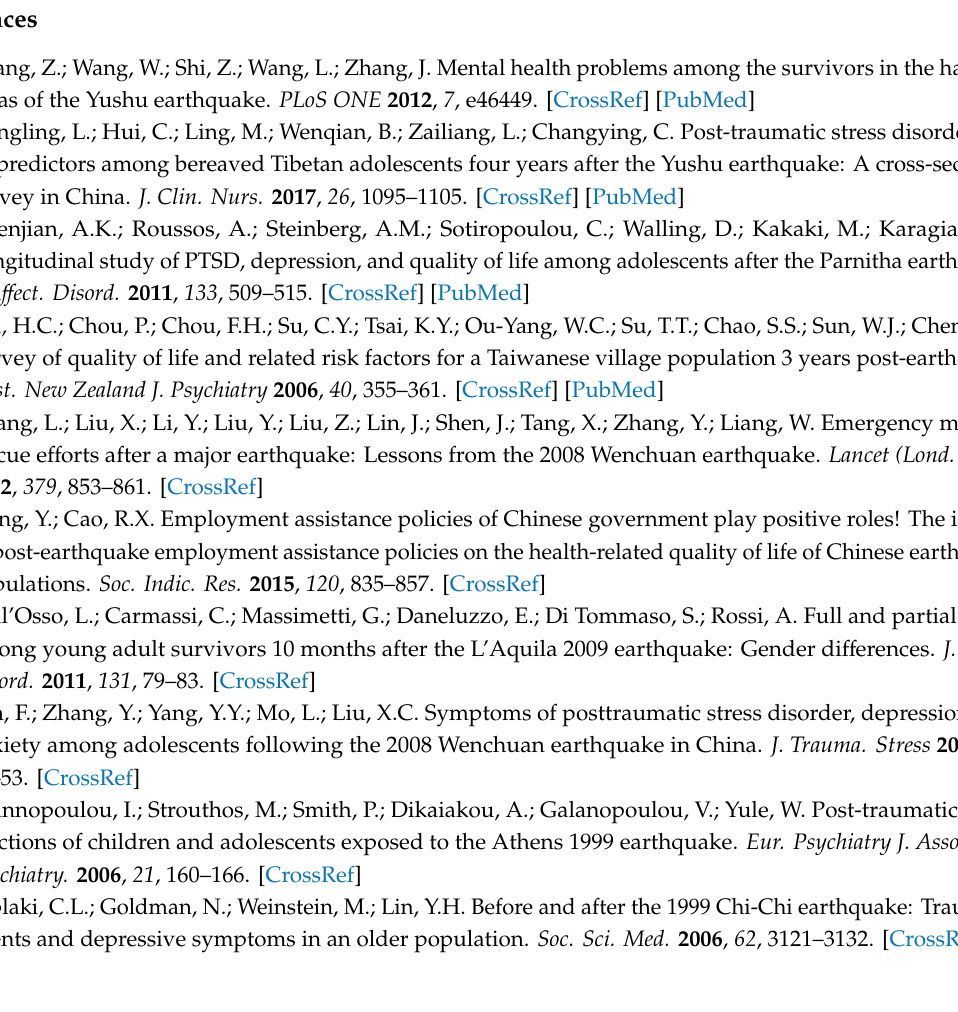
Table S1: Univariate analyses of ASAS and subscales among adolescent survivors ( N =